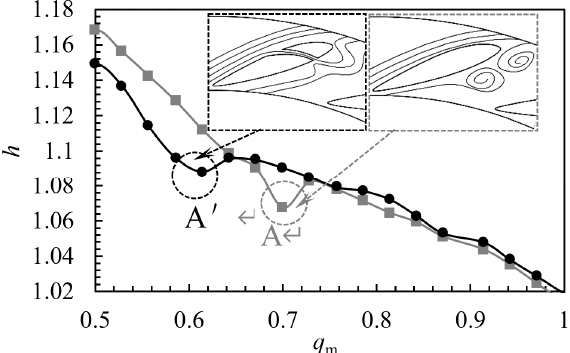
Figure 8. Calculation verification of the “Groove Method” to suppress head hump.